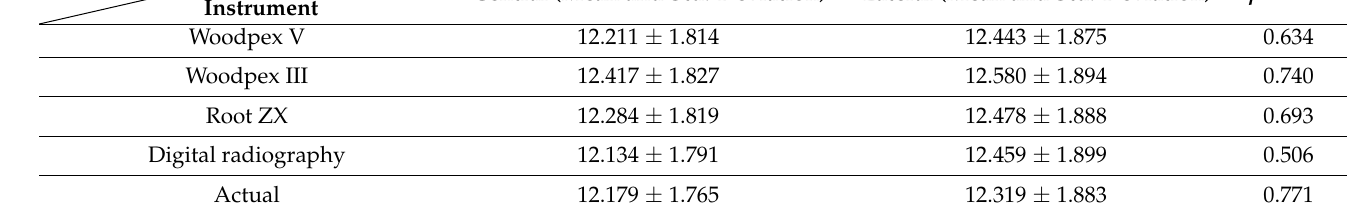
Table 3. Effect of position of apical foramen (central/lateral) on the accuracy of working length measurement by different instruments.